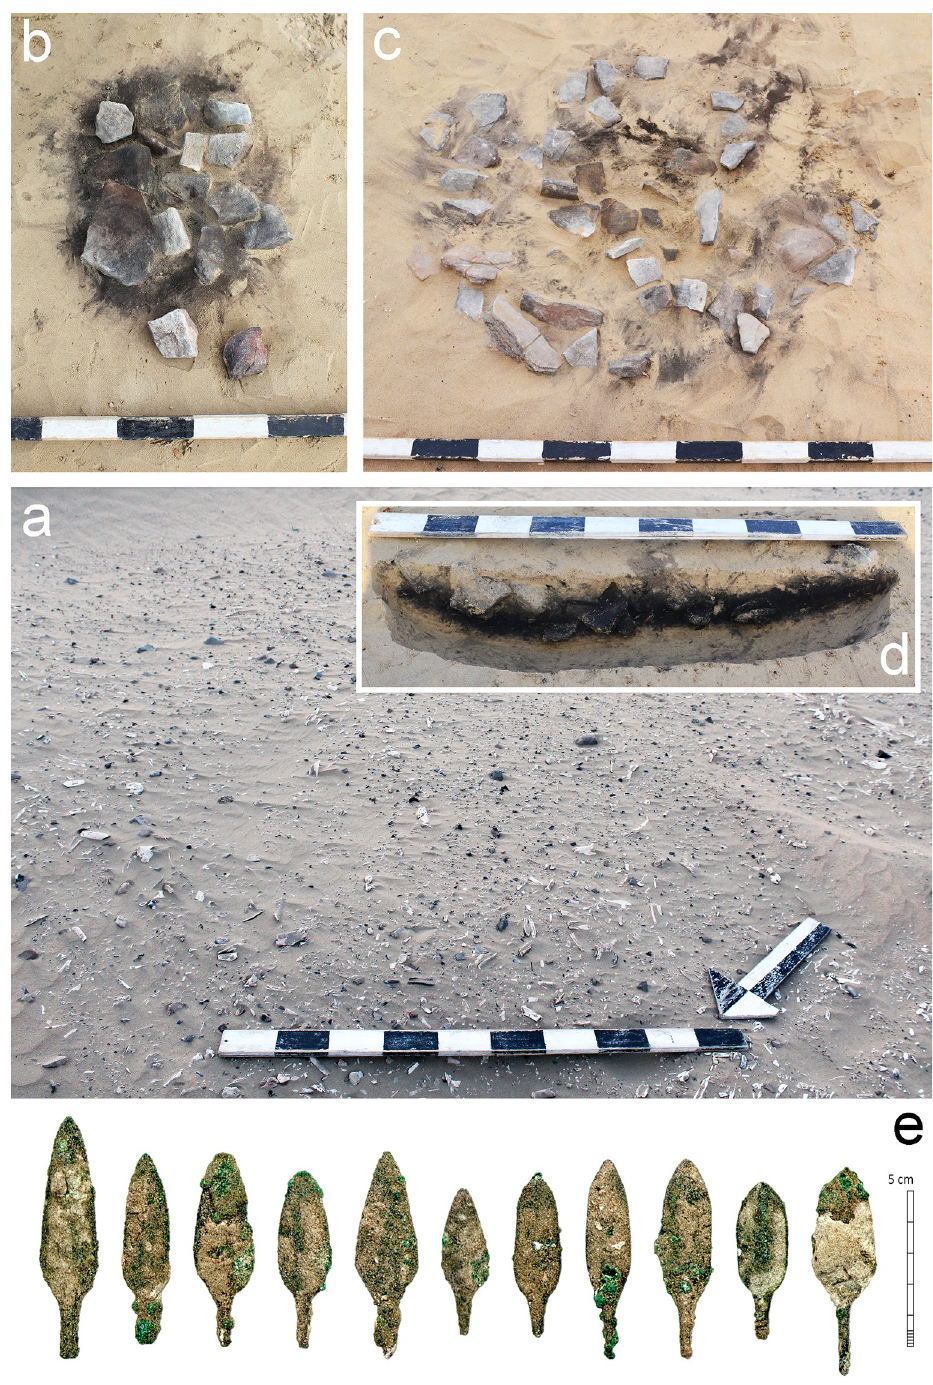
Fig 2. Cooking features and metal artefacts from the bone midden, Horizon IV, Saruq al-Hadid. (A) Bone midden prior to excavation. (B-D) Cooking features from contexts 2328 (B), 2332 (C), and 2338 (D). (E) Copper-base arrowheads from Horizon IV contexts (courtesy of He´l è ne David-Cuny). Scale bar 10 cm increments (A-D).